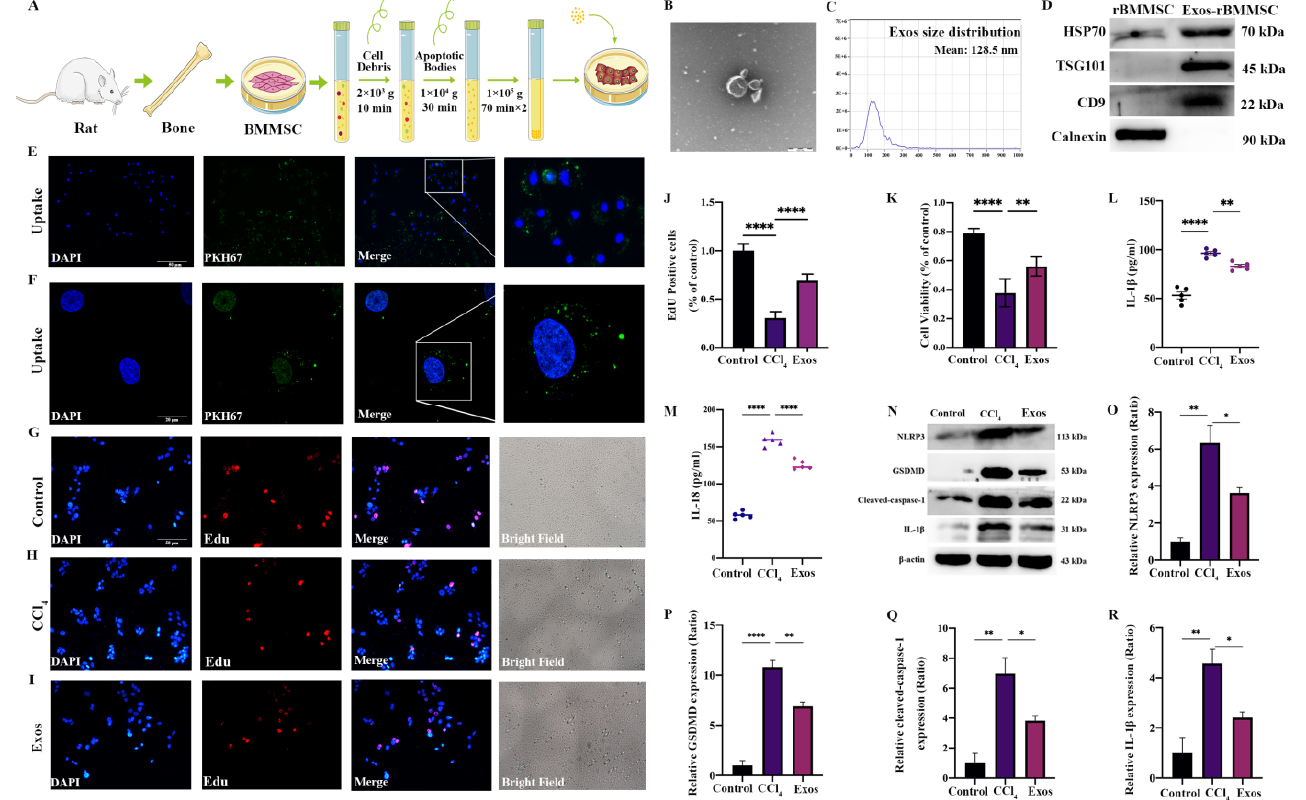
Figure 3. Effects of Exos-rBMMSCs on CCl 4 -induced hepatocytes. The extraction protocol of